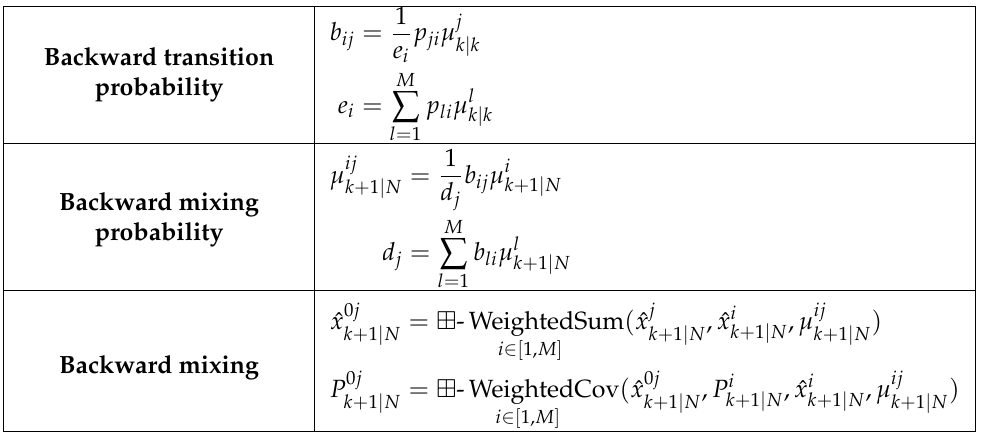
Table 2. The (cid:1) -RTSIMMS smoothing scheme based on